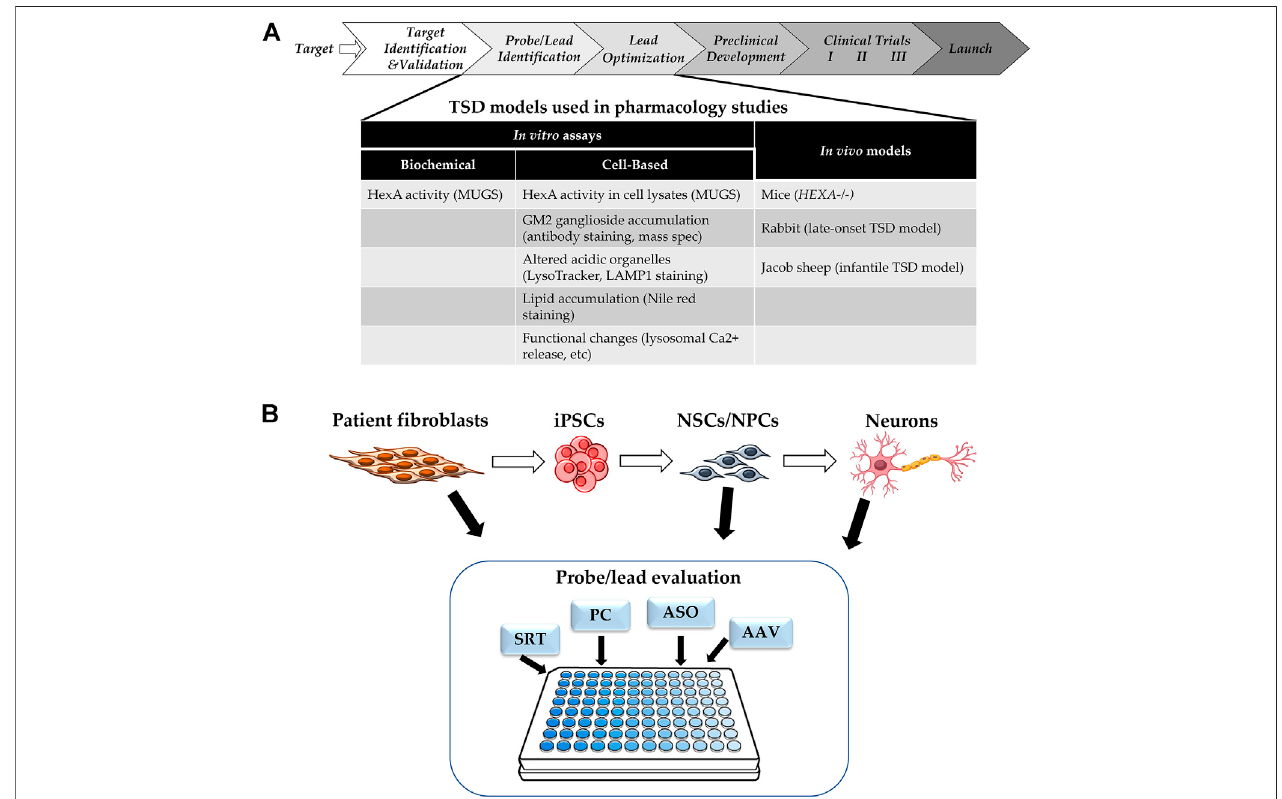
FIGURE 2 | (A) Drug Development Progression. Pipeline of drug development with TSD speci fi c assays and models. (B) Cell-based Assays for TSD. SRT: substrate reduction therapy, PC: pharmacological chaperone, ASO: antisense oligonucleotide, AAV: adeno-associated virus for gene therapy.